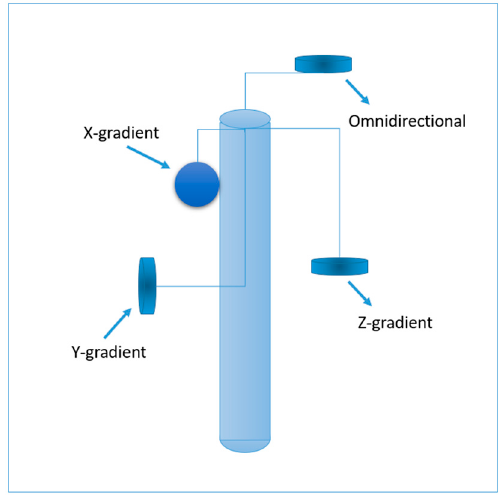
Figure 4. XYZO-AVS array.